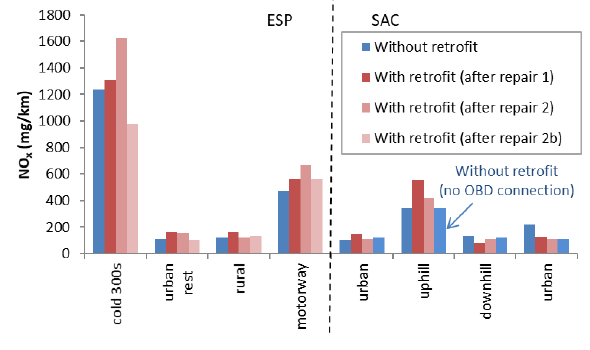
Fig. 7. NO x results for the on-road tests Table 8. Summary of retrofit results (as reported by Dr. Pley). F = Fail, P = Pass based on the Retrofit limits because the prototype vehicle was deliv- ered for the Retrofit prize (Table 1). For the lab tests the average of the three cycles was considered as pass/fail criterion. Lim. = Limits Criteria